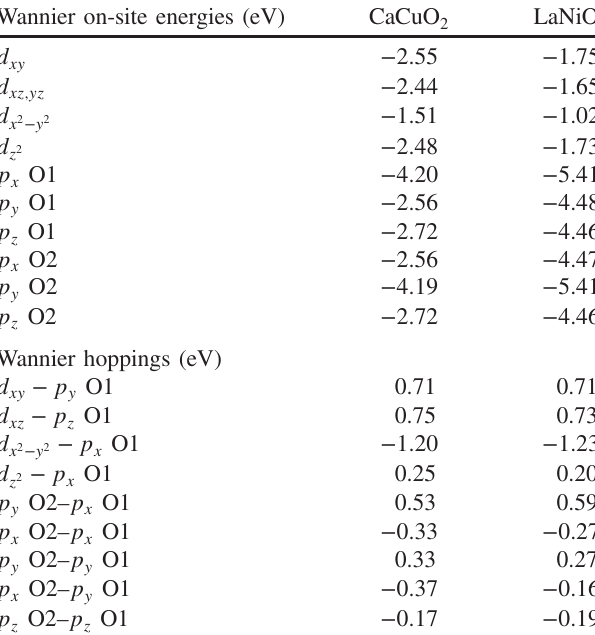
CaCuO 2 and LaNiO 2 derived from the Wannier functions. O1 bonds to Ni = Cu along the x direction, and O2 bonds to Ni = Cu along the y direction.